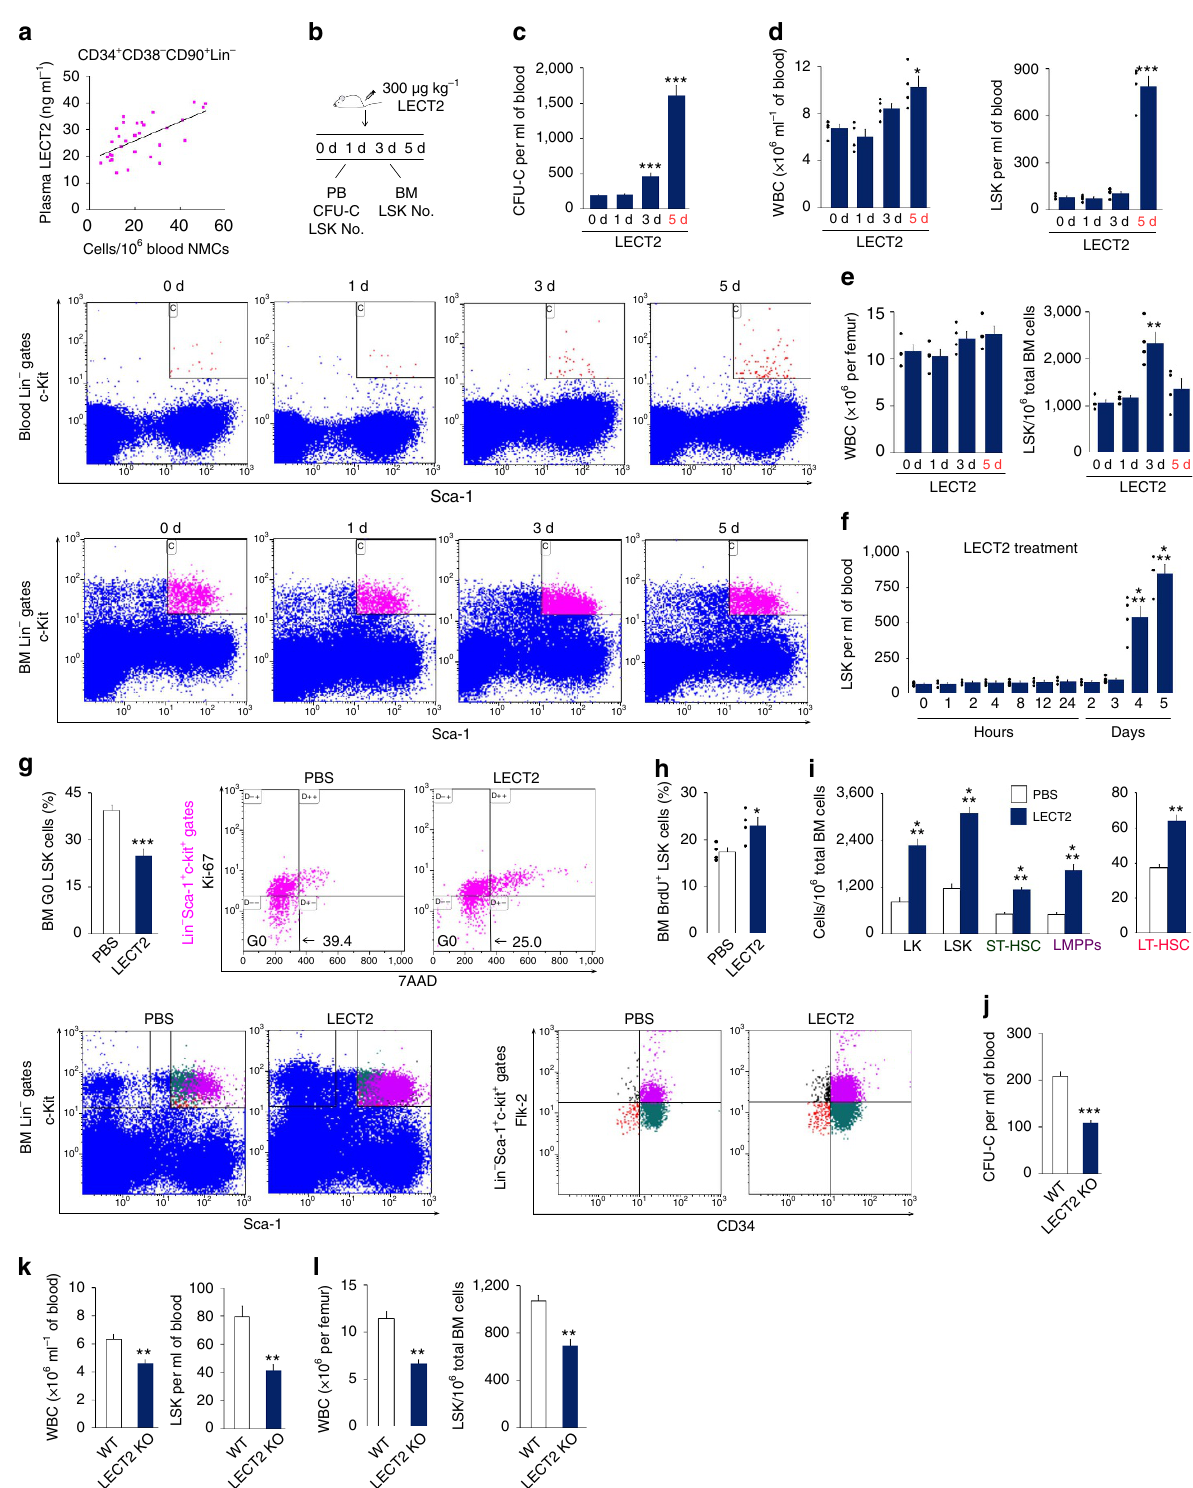
Figure 1 | LECT2 increases the mobilization and expansion of HSCs and their transplantation potential. ( a ) The correlation between human plasma LECT2 levels and the number of CD34 þ CD38 (cid:2) CD90 þ Lin (cid:2) cells in the blood (Pearson correlation coefficient ¼ 0.624, P o 0.001); n ¼ 31. ( b ) The protocol used to evaluate the effect of LECT2 on HSC homeostasis. ( c ) The number of CFU-Cs per millilitre of mouse blood; n ¼ 10. ( d ) The number of WBCs and LSK cells in the blood. ( e ) The number of WBCs and LSK cells in BM. ( f ) The number of LSK cells in the blood at different time points after LECT2 administration. ( g , h ) Percentage of quiescent G0 ( g ) and BrdU þ ( h ) LSK cells in the BM of LECT2-treated mice. ( i ) Effects of LECT2 on the number of LK cells, LSK cells, LT-HSCs, ST-HSCs and LMPPs in BM. n ¼ 5. ( j – l ) The number of CFU-Cs ( j ), WBCs and LSK cells ( k ) in the blood and the number of WBCs and LSK cells ( l ) in the BM of LECT2 KO mice; n ¼ 5. The small black dots in histograms are data points. The data represent means ± s.e.m. The data are representative of two ( d – l ) and three ( a , c ) independent experiments. * P o 0.05, ** P o 0.01, *** P o 0.001 using Pearson’s correlation coefficient analysis ( a ) and one-way analysis of variance (ANOVA) ( c – l